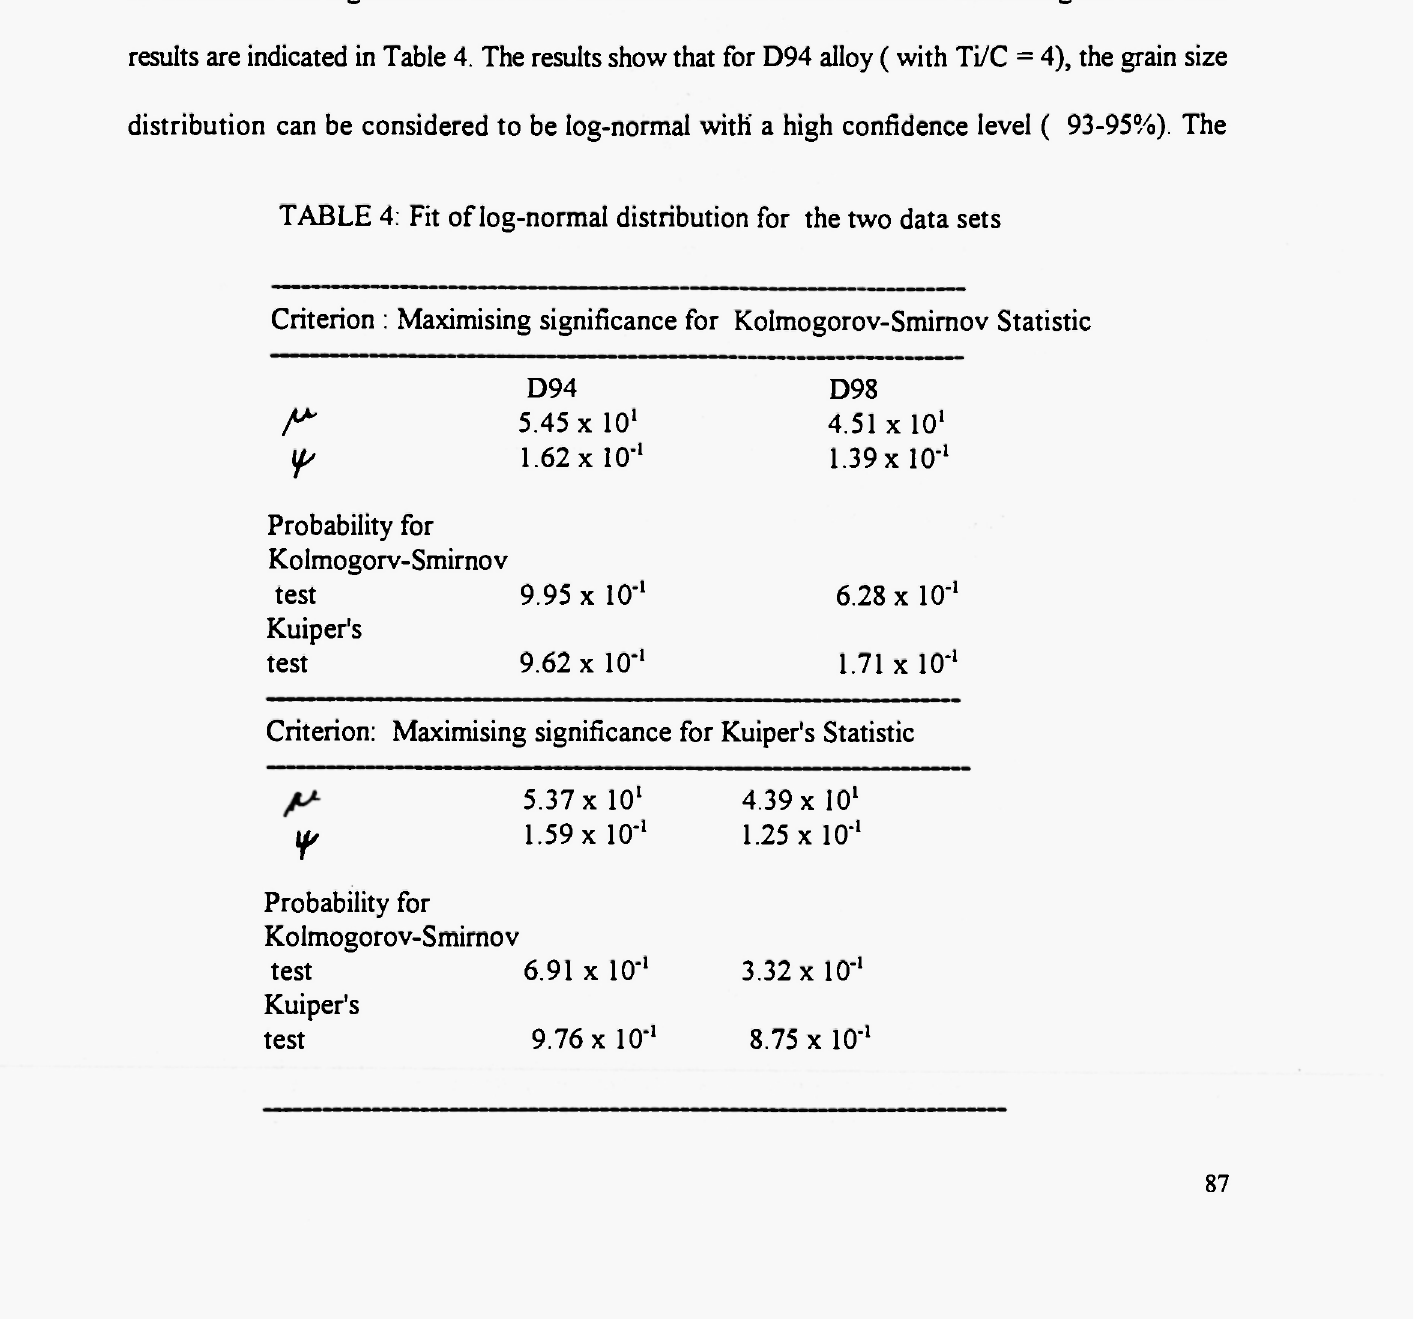
TABLE 4: Fit of log-normal distribution for the two data